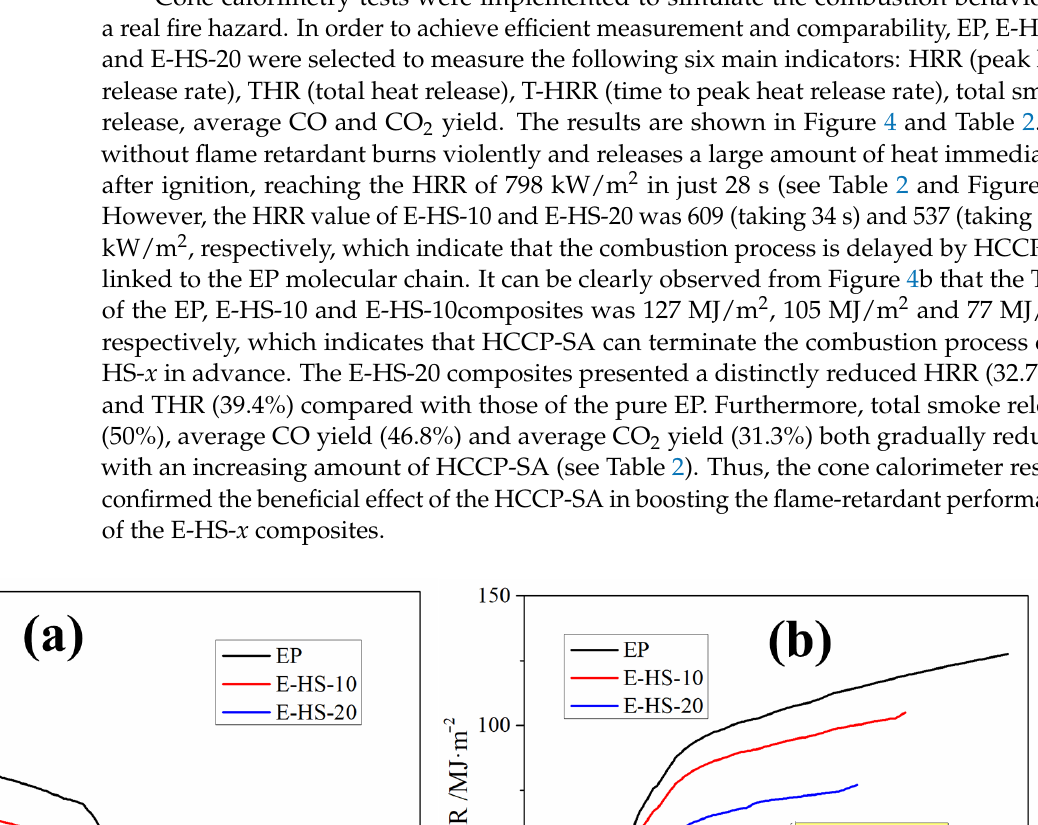
Table 2. Data from cone calorimetry tests.